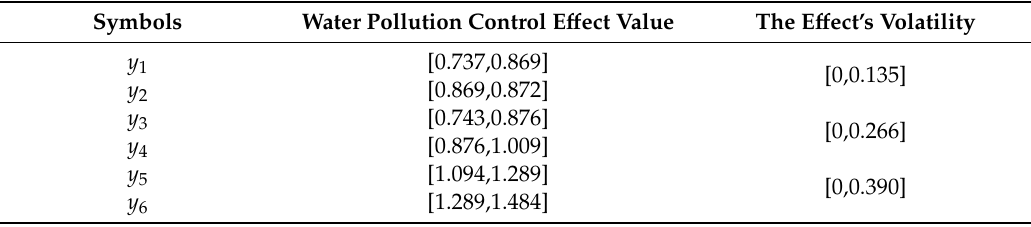
Table 6. The water pollution control e ff ect and the e ff ect’s